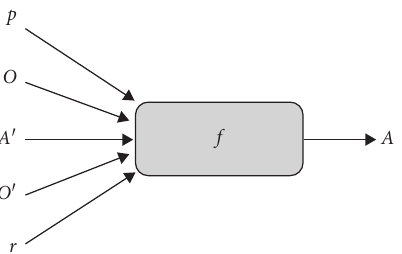
Figure 1: The process of ontology